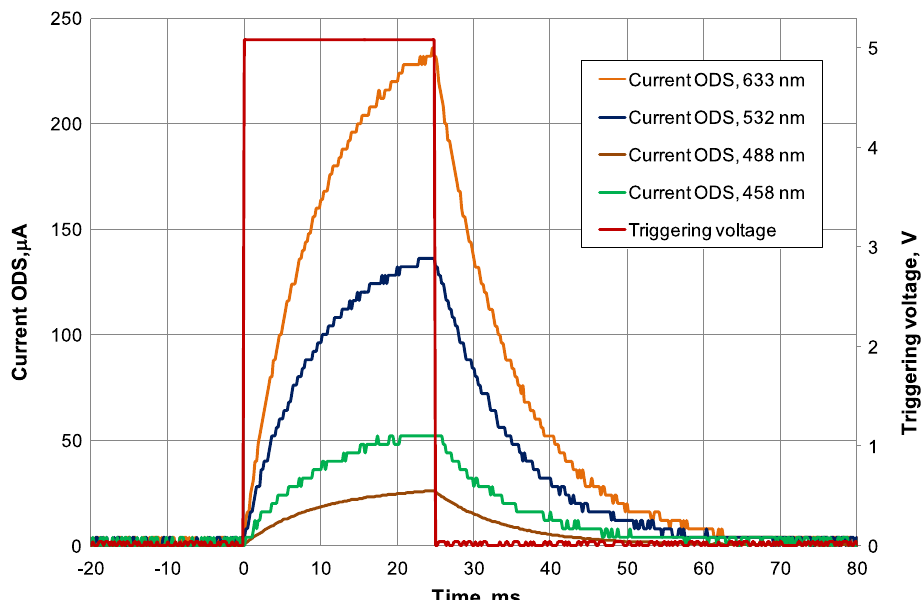
Fig. 9. Time-resolved spectrally fi ltered optical signal of the short-pulse driven CoB (ID VSL096). Triggering electrical forward voltage is shown in red for reference.